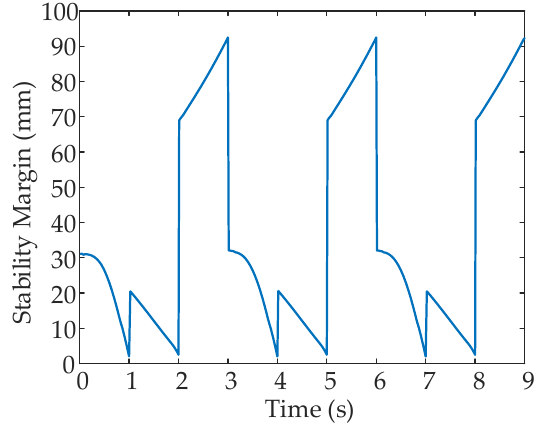
Appl. Sci. 2020 , 10 , x FOR PEER REVIEW Figure 17. The displacement of the hexapod body with leg 1 fault. Figure 17. The displacement of the hexapod body with leg 1 fault. Figure 17. The displacement of the hexapod body with leg 1 fault.